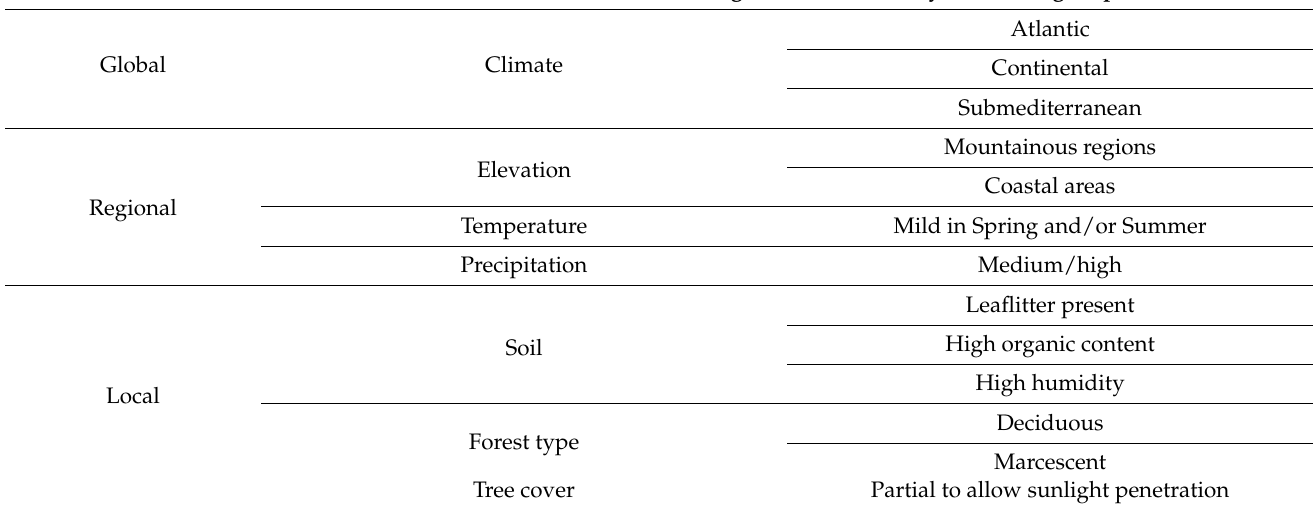
Table A1. Known environmental factors rationale based on previous expert-knowledge about the target species describing their broad ecological preferences, at different scales.